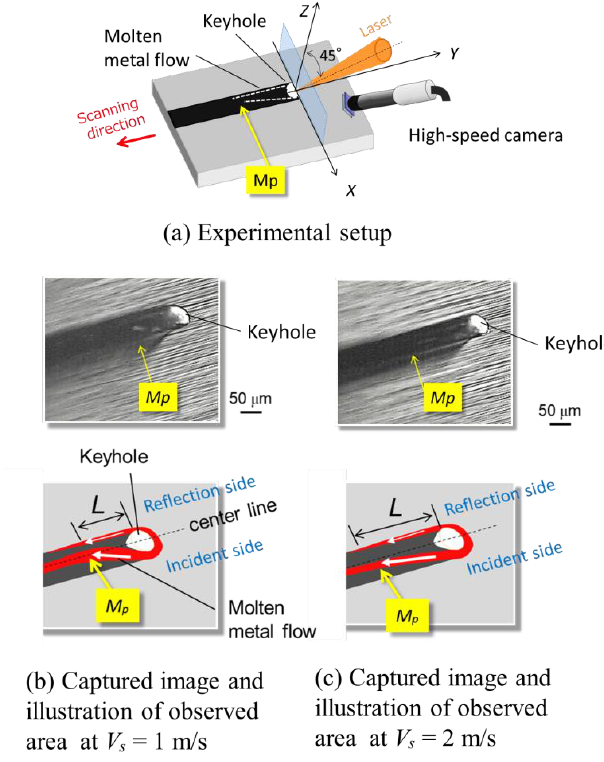
Figure 5. High-speed observation of processed surface.